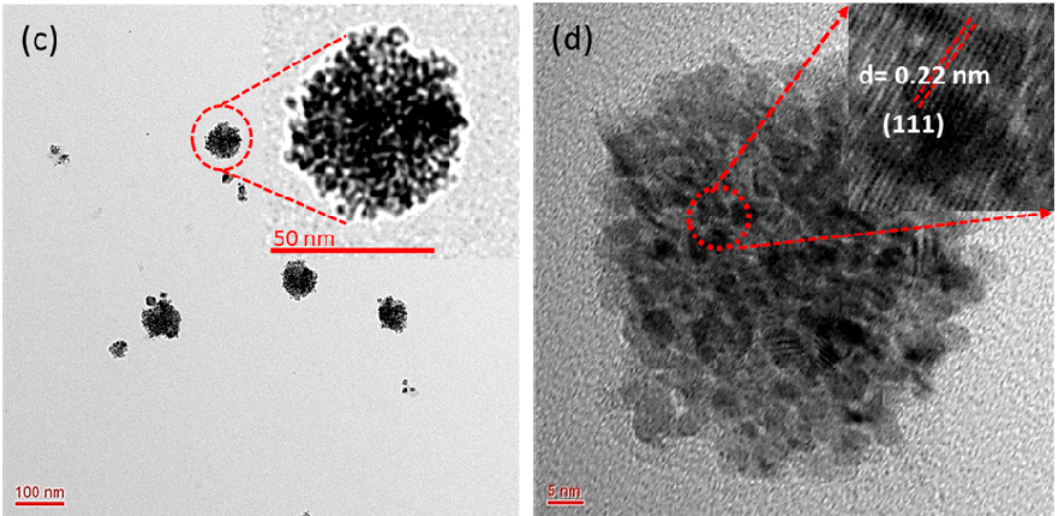
Figure 2. Transmission electron microscopy (TEM) micrographs of the PdNCs at different magnifications: ( a ) Wide scan of the sample at 0.2 μ m for an overall view; ( b ) Uniformity of the nanoclusters at low magnification, the inset shows the nanoclusters size distribution histogram; ( c ) Scan focused on a small area of the sample in which the inset shows a zoomed-in view of a single nanocluster; ( d ) High resolution (HR)-TEM image showing the crystalline nature of the nanoclusters in which the inset shows the inter-atomic spacing (d-spacing).